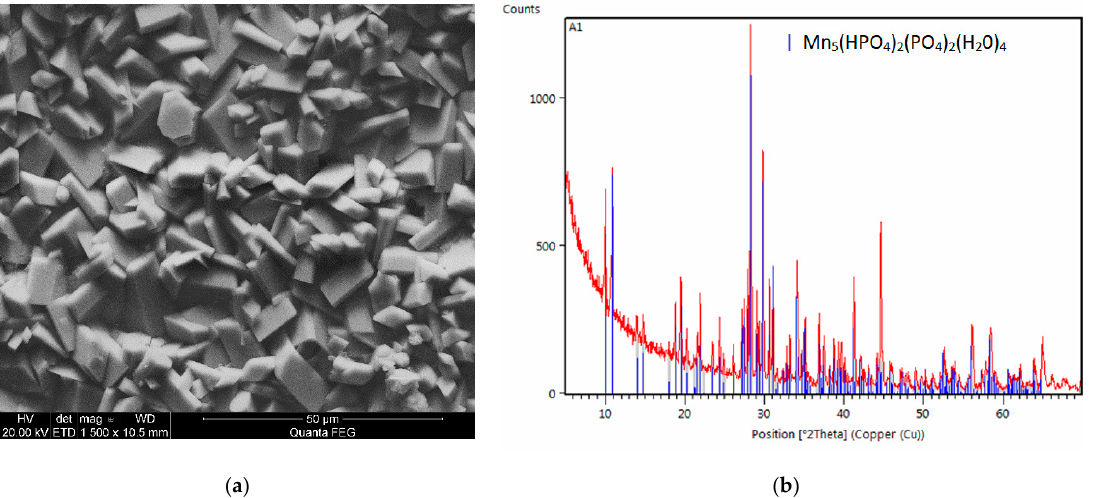
Figure 18. Microphotograph of the coating modified with cerium nitrate ( a ) and XRD spectrum ( b ).